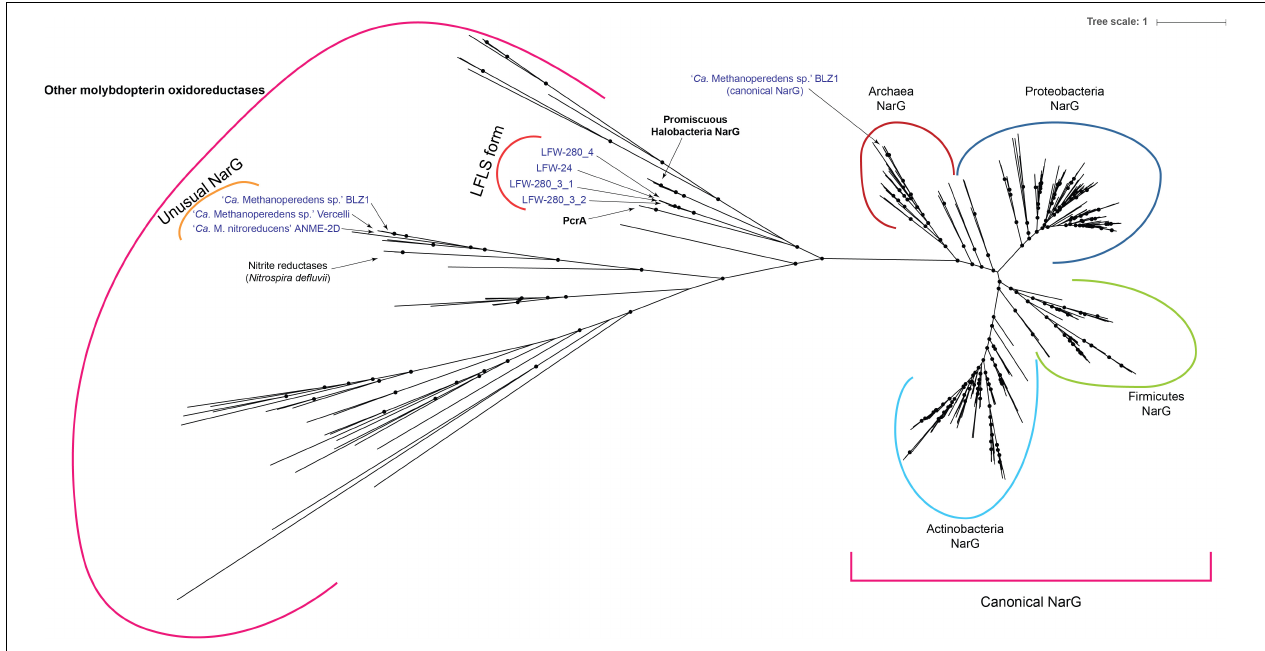
FIGURE 7 | Phylogenetic analysis of molybdopterin oxidoreductase proteins. Tree was generated with 268 reference sequences and 8 query sequences from ‘ Ca. Methanoperedens’ spp. NarG(-like) proteins. Tree was built under model LG + R10 model and 10,000 ultrafast bootstrap iterations. Branches with ultrafast bootstrap support values < 50% are collapsed. Black circles indicate a branch support ≥ 90%.